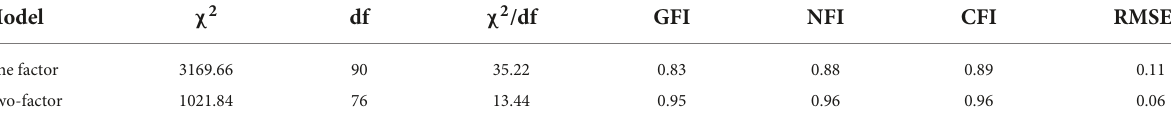
TABLE 5 Fitting indices of model ( n =